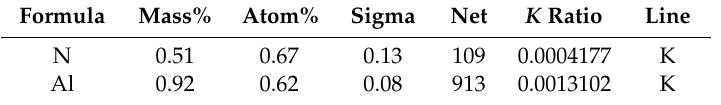
Figure 4. EDS spectrum of AlN nanoparticles deposited on the glass substrate. Table 1. Element analysis determined by the EDS for the AlN nanoparticles on the glass substrate.